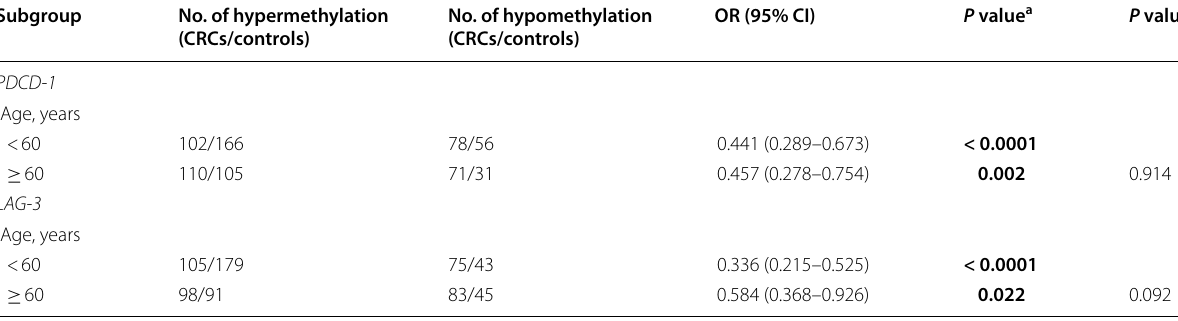
CRC, colorectal cancer; CI, confidence interval; OR, odds ratio a P values were calculated using Logistic regression analysis, P values < 0.025 were considered statistically significant and were indicated in bold b Test for heterogeity between ORs was conducted by fixed effect models with STATA (version 14), P values < 0.05 were considered statistically significant